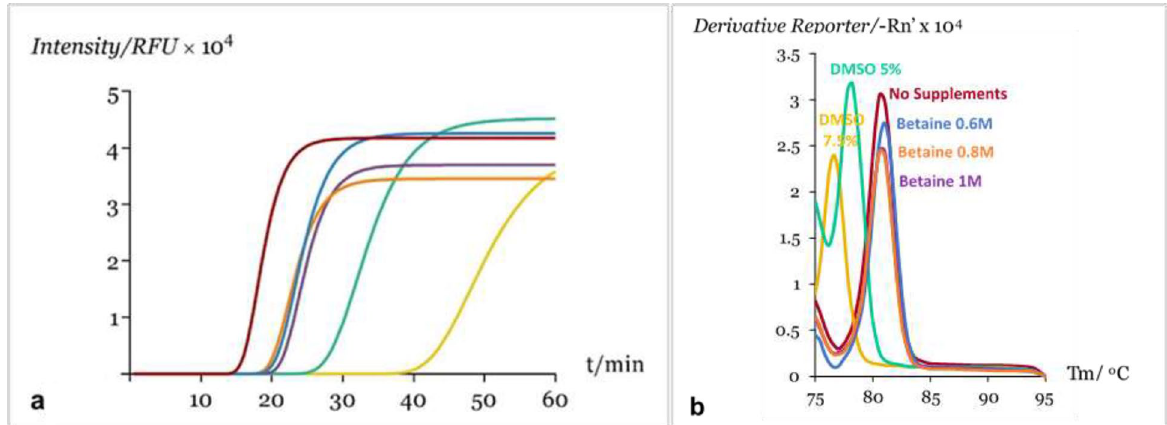
Figure 1. Effect of supplement addition on the qLAMP method. ( a ) qLAMP kinetics in pure D. polymorpha DNA (C+) according to the fittings from Eq. (1) performed using GraphPad Prism version 8.0.0 for Windows, GraphPad Software, San Diego, California USA, www. graph pad. com: (deep red line) “C+ No supplement”, (blue line) “C+ Betaine 0.6 M”, (orange line) “C+ Betaine 0.8 M”, (purple line) “C+ Betaine 1 M”, (green line) “C+ DMSO 5%”, (yellow line) “C+ DMSO 7.5%”; ( b ) Respective melt